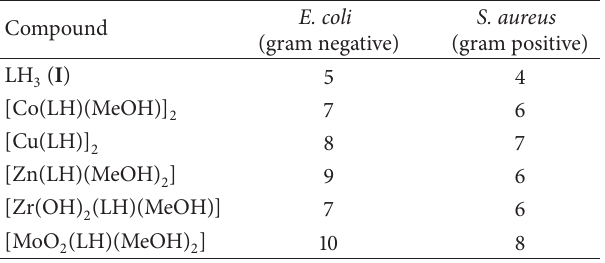
Table 3: Antibacterial activity of ligand ( I ) and its coordination compounds (zone of inhibition in